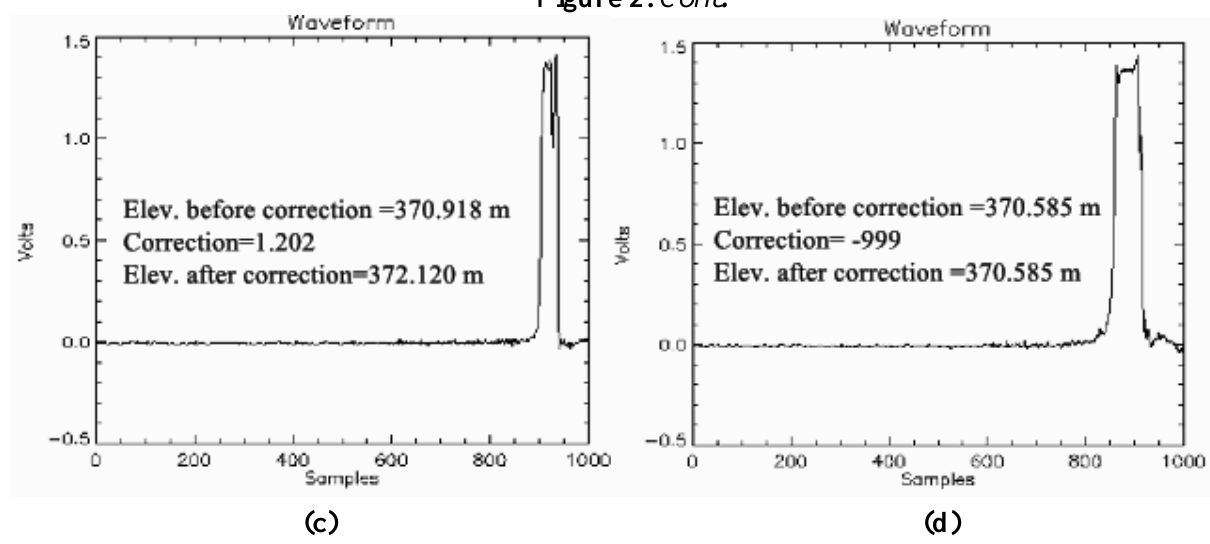
Figure 3. ICESat elevations across Lake Leman extracted from the 3 June 2005 transect. The reference elevation is 372.18 m. Ordinate = energy in volts and abscissa = bin number (bin spacing = 1